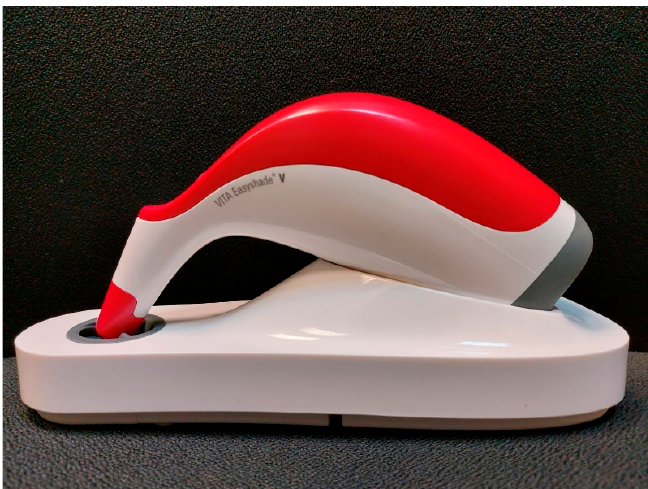
Figure 4. Vita Easyshade ® V, Bad Säckingen, Germany.